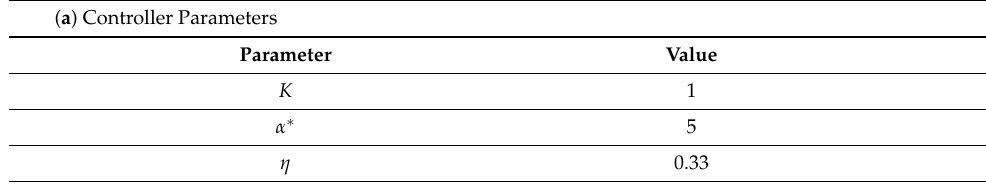
Table 2. Network parameters and load variation in boost